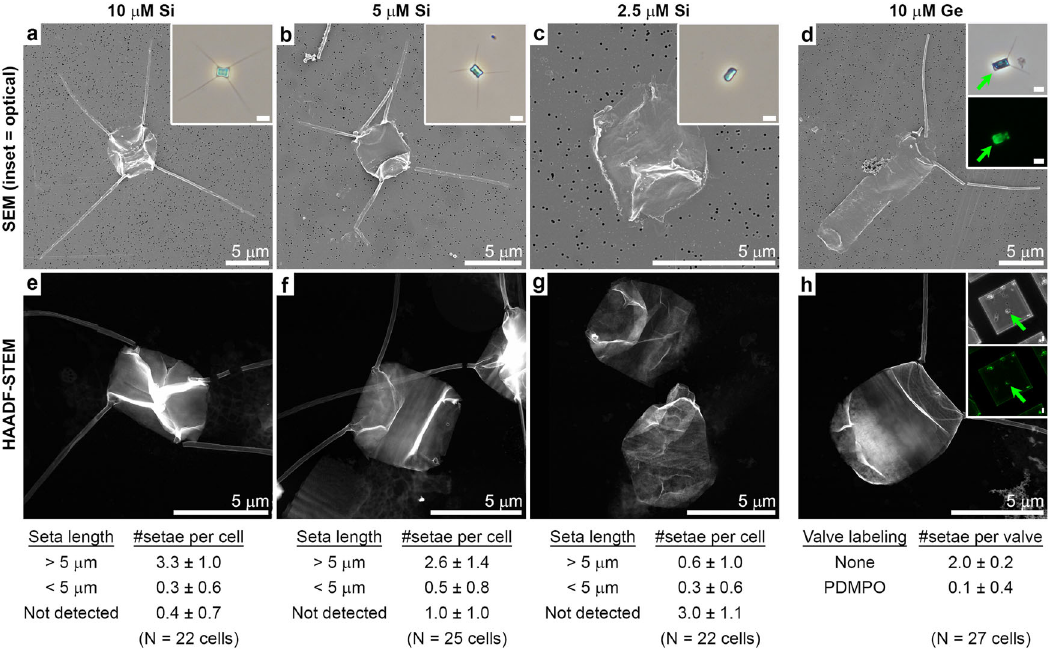
Fig. 5 The in fl uence of Si concentration and Si inhibitor in the growth medium on seta formation. a – d SEM images of cells that were blotted dry for imaging, the insets show live cells. e – h HAADF-STEM images of washed and dried cell walls. The contrast in these images arise from the density of the material and is more affected by the folding of the cell walls then from actual variable densities of the material. Insets in d and h show optical microscopy images of the same cells as in the main panels. The fl uorescence of PDMPO, which was added with Ge to the growth medium, allowed the identi fi cation of speci fi c valves (indicated with green arrows) that formed in the presence of Ge. These valves do not have setae. For each experimental condition, a statistical summary of the average number and standard deviation of setae is presented below the images. In the different Si concentrations ( a – c , e – g ), the number of setae declines from a value that is close to the ideal four setae per cell to almost no setae at all. In the Ge-treated culture ( d , h ), the valves that are labeled with PDMPO, thus the ones that formed in the presence of Ge, have almost no setae, while the unlabeled valves that form prior to Ge addition have the expected two setae per